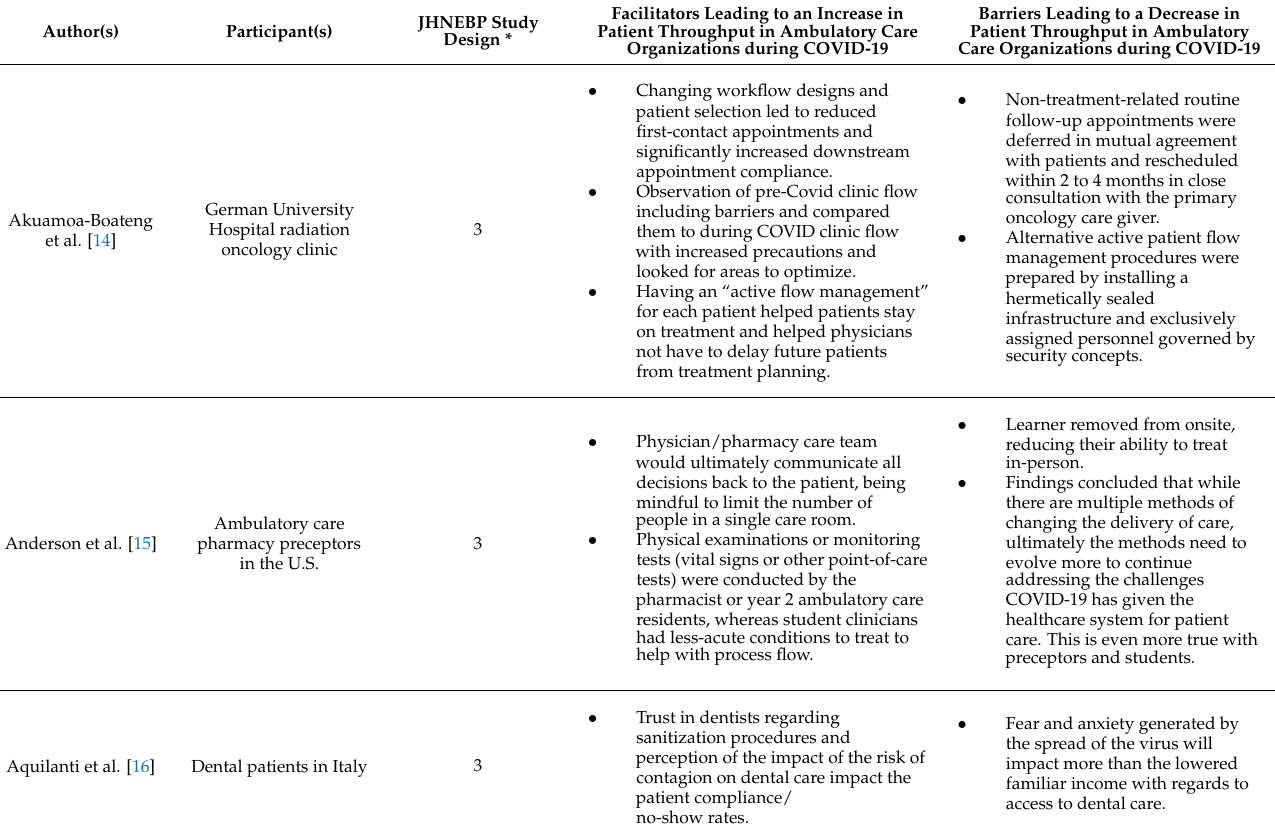
Table 3. Summary of findings ( n =